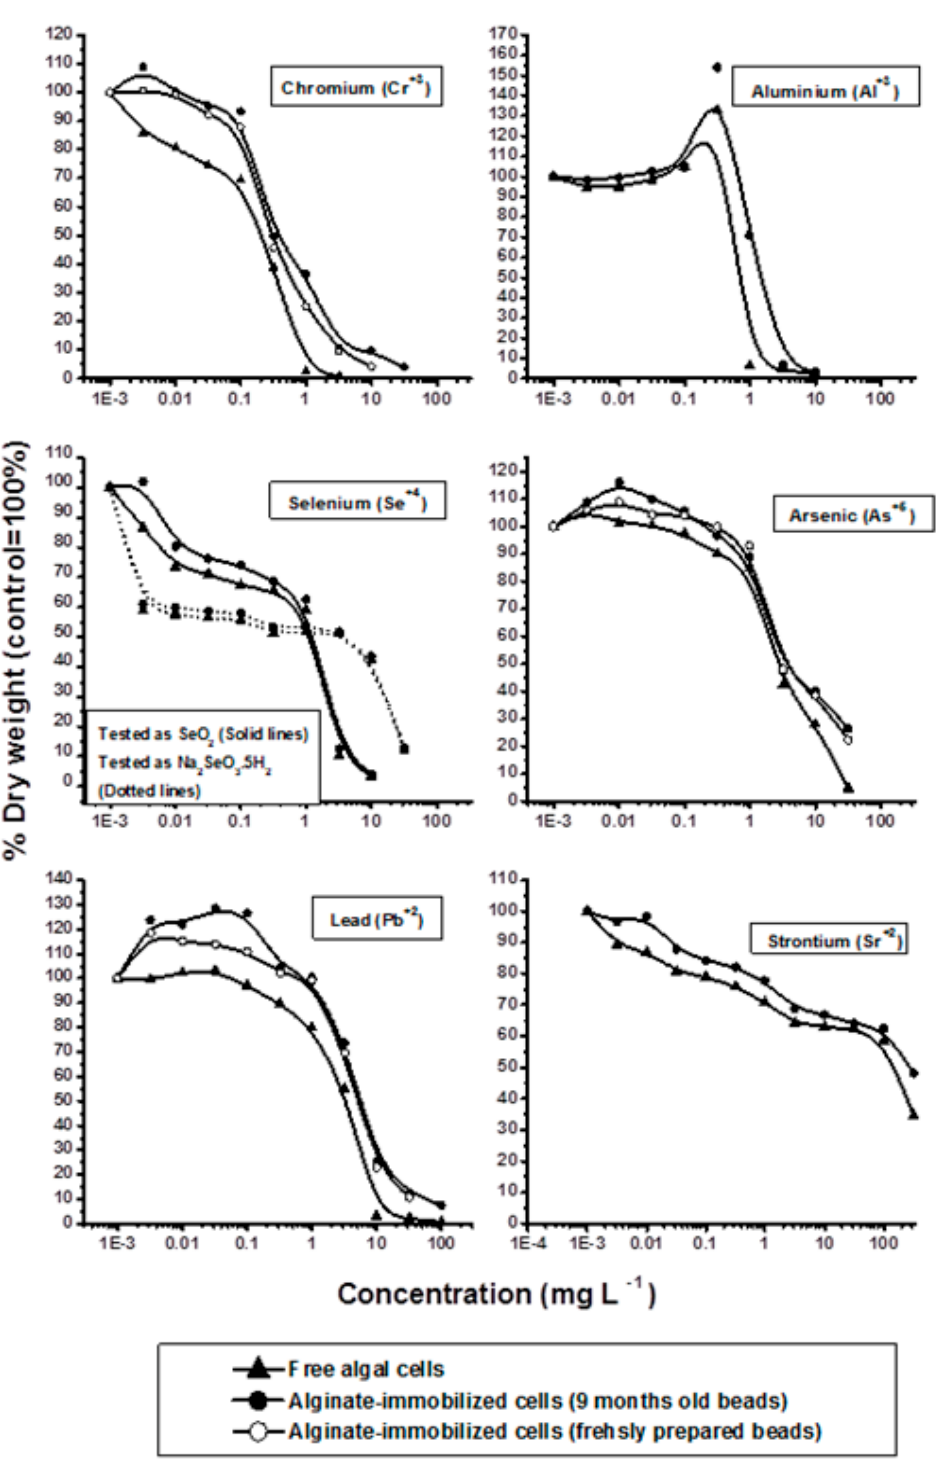
Figure 2. Effect of Cr, Al, Se, As, Pb and Sr on growth of free and alginate-immobilized cells of Pseudokirchnerilla subcabitata .